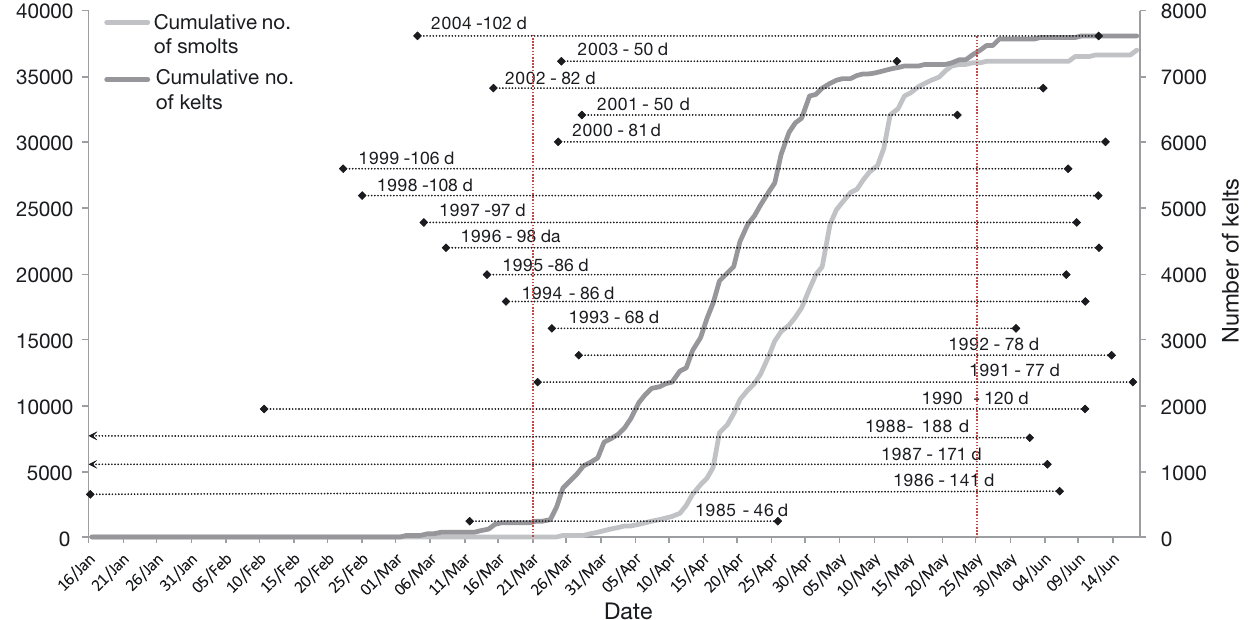
Fig. 3. Annual trapping duration on the Erriff River, and cumulative number of sea trout Salmo trutta smolts and kelts over a 20 yr period (1985−2004). Data were generated by adding the daily run of smolts and kelts by date each year. Red lines indicate main smolts and kelts run